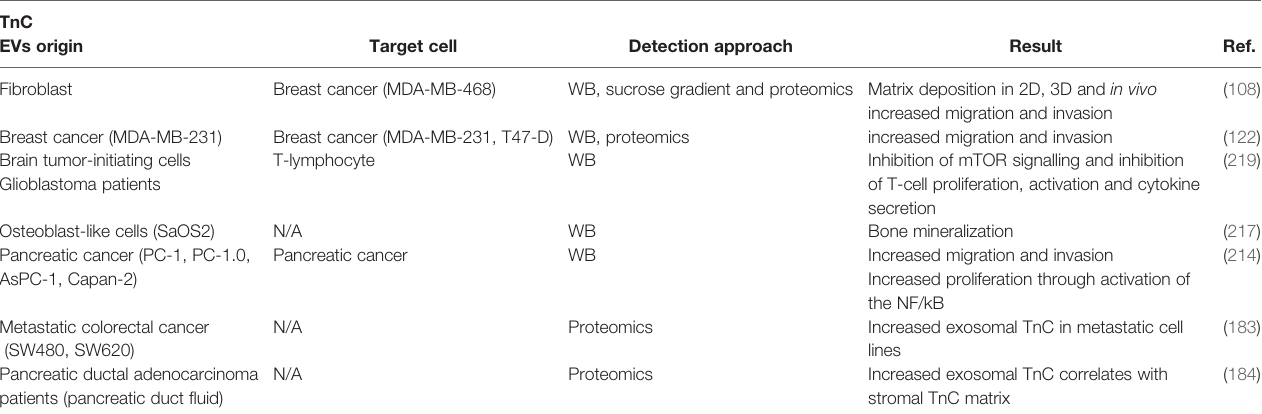
TABLE 2 | Literature contributing evidence of TnC as an EV secreted cargo. EVs origin: cell type/tissue from which EVs containing TnC were detected; WB: western blotting.